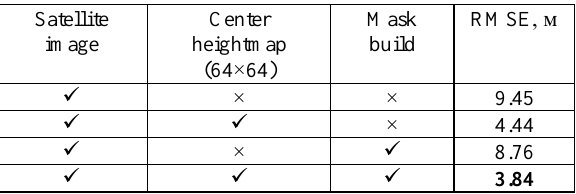
Table 5. 3D reconstruction with different pipelines